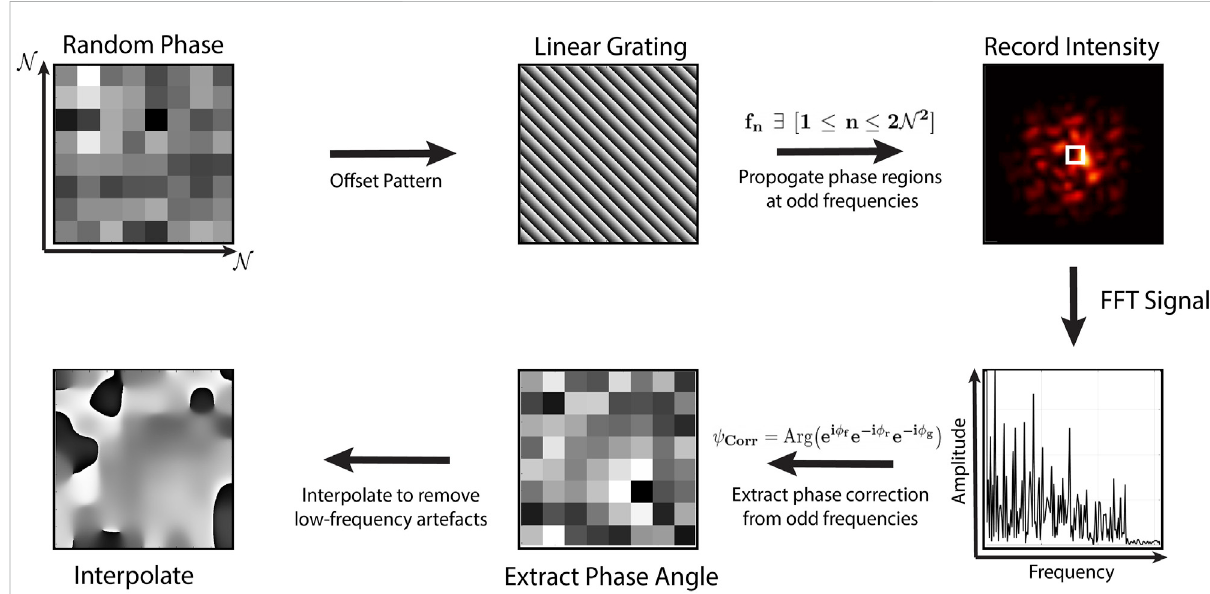
FIGURE 2 Phase retrieval: We start by dividing the SLM into N × N equal regions, each with an initally random phase value ( ϕ r ), which is then offset from the zeroth order spot with a linear diffraction grating ( ϕ g ). A central square in the center is then kept at a constant phase whilst all other grids are incrementally propagated at odd-integer frequencies ( f n ) between 0 and 2 π . As the pattern evolves, the intensity within a small central region is recorded at each step. Once complete, the intensity signal is Fourier transformed. Only the odd-frequency components are retained ( f n (cid:2) [ 1 , 3 , 5 , 7 ... ..2 N 2 ]) and the phase pattern which maximises interference ( ψ Corr ) is found by taking the argument of these signal components. The initial random phase and linear grating are then removed to reveal the zeroth order correction, ψ Corr (cid:2) Arg ( e i ϕ f e − i ϕ r e − i ϕ g ) . Finally this pattern is interpolated to remove discontinuities between grids which would appear as low-frequency artefacts near the beam